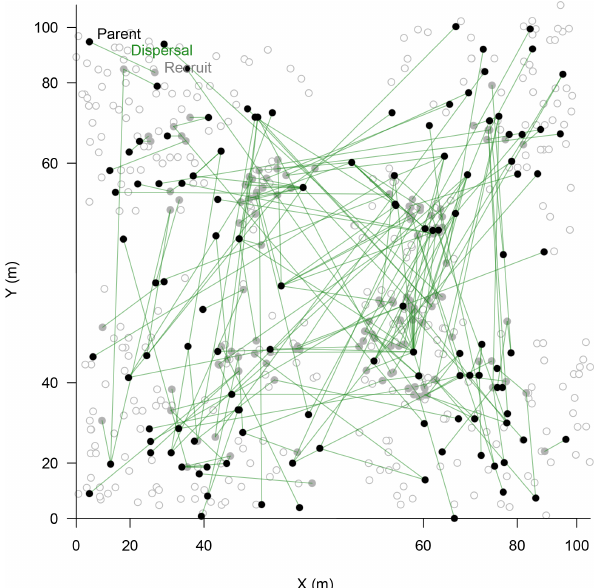
Figure 4. Map of assigned relationships between parents (filled black circles) and their offspring (filled bright circles) of Larix gmelinii individuals. Additional genotyped individuals are given as open circles. Note the non-linear scale of the coordinates.